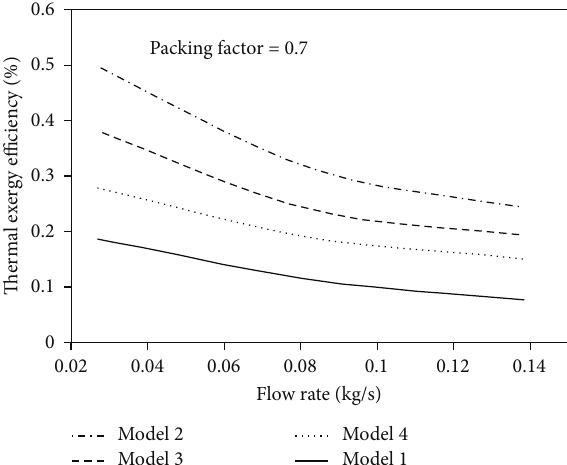
Figure 5: Thermal exergy efficiency of the four panel designs.